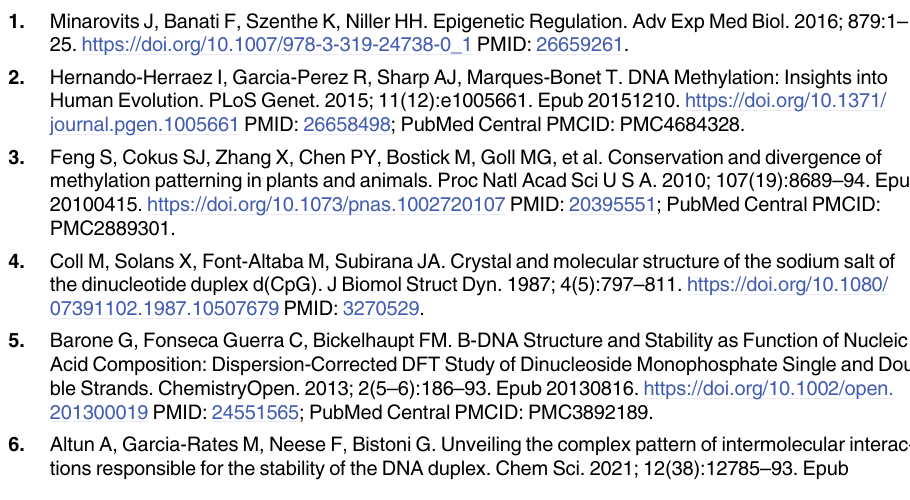
S1 Table. Exon-specific synonymous base changes in CpG- vc- Trp53 mice. CpG sites are highlighted. S2 Table. Exon-specific synonymous base changes in CpG+ vc- Trp53 mice. CpG sites are highlighted.